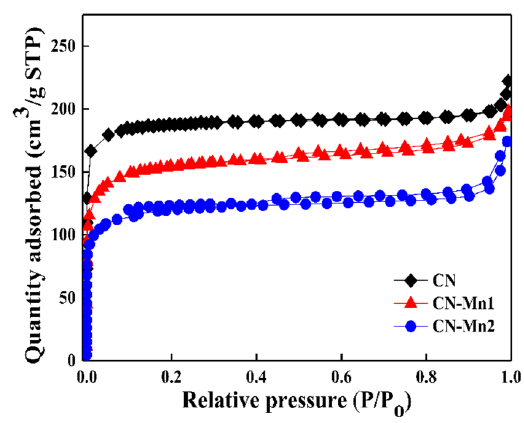
Figure 3. Nitrogen adsorption‐desorption isotherms of the CN, CN‐Mn1 and CN‐Mn2.